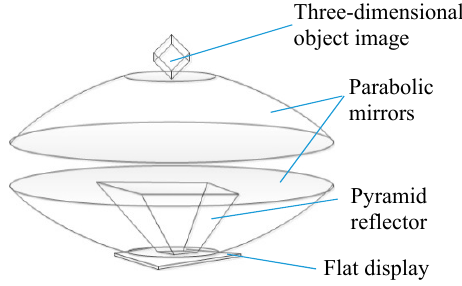
Figure 8. Pyramid reflector and parabolic mirrors.